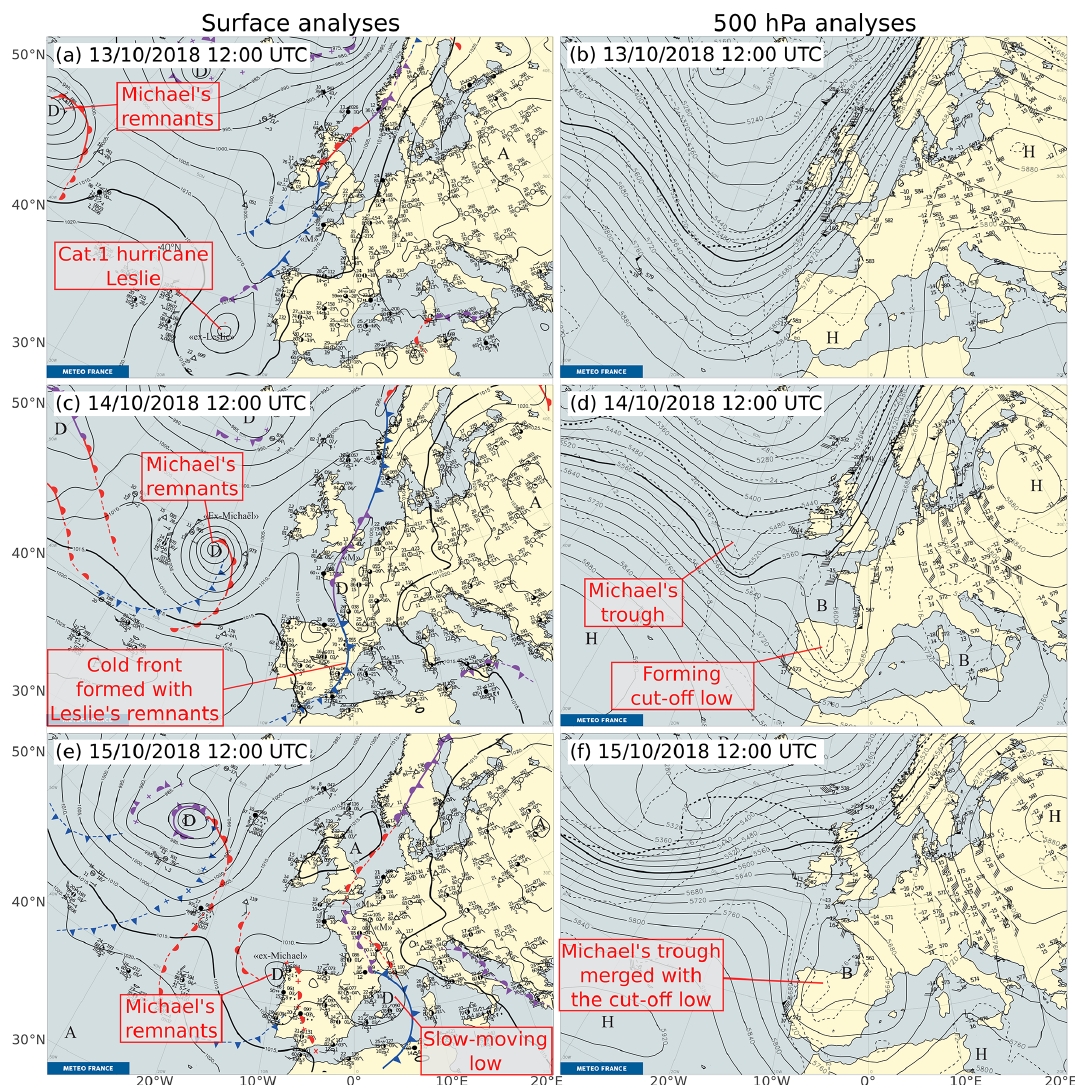
Figure 3. Météo-France (a, c, e) surface and (b, d, f) 500hPa analyses (Santurette and Joly, 2002) at (a, b) 12:00UTC on 13 October 2018, (c, d) 12:00UTC on 14 October 2018 and (e, f) 12:00UTC on 15 October 2018. Surface fronts are manually drawn using conventional observations, satellite and radar images, and short-term forecasts (instead of analyses due to availability time constraints). Mean sea level pressure (in hPa), 500hPa geopotential height (in geopotential metres, gpm) and temperature (in ◦ C) are from the operational global model ARPEGE (Courtier et al., 1991) 6h forecast of the T − 6h run ( T : time of the chart). Surface (altitude) low-pressure centres are indicated by “D” (“B”) and high-pressure centres by “A”